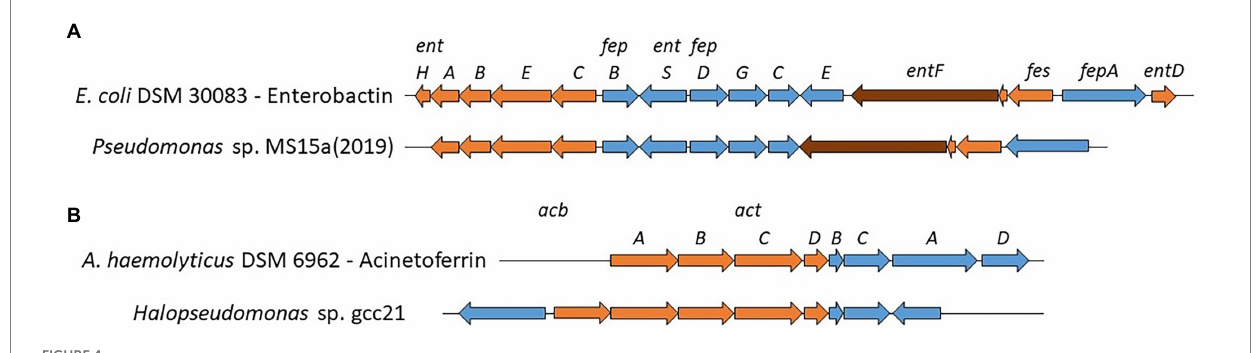
FIGURE 4 Known and proposed gene clusters involved in the biosynthesis of Enterobactin (A) and Acinetoferrin (B) . All genes are scaled to the depicted size. Biosynthesis genes are highlighted in orange (NRPS in brown) and transport genes in